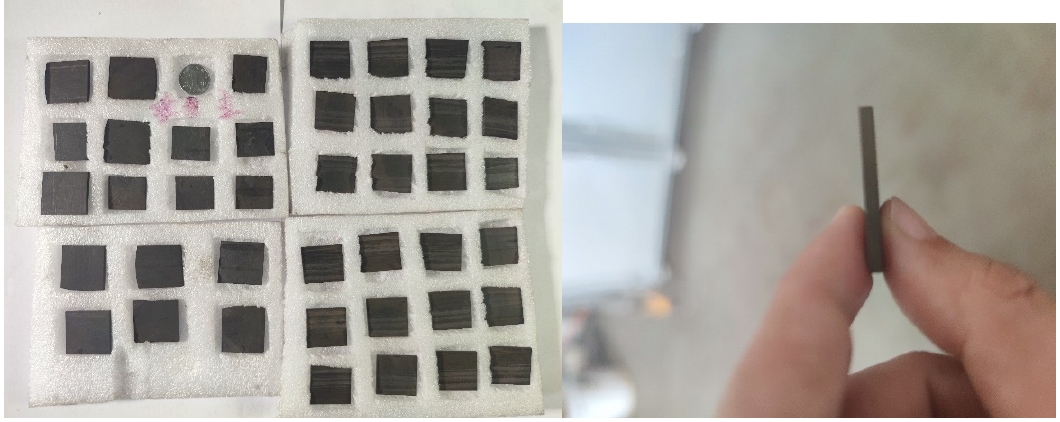
Figure 3. Schematic diagram of the heat conduction direction [32]. ( a ) Perpendicular to bedding; ( b ) parallel to bedding. (Yu et al. 2015 [31]).